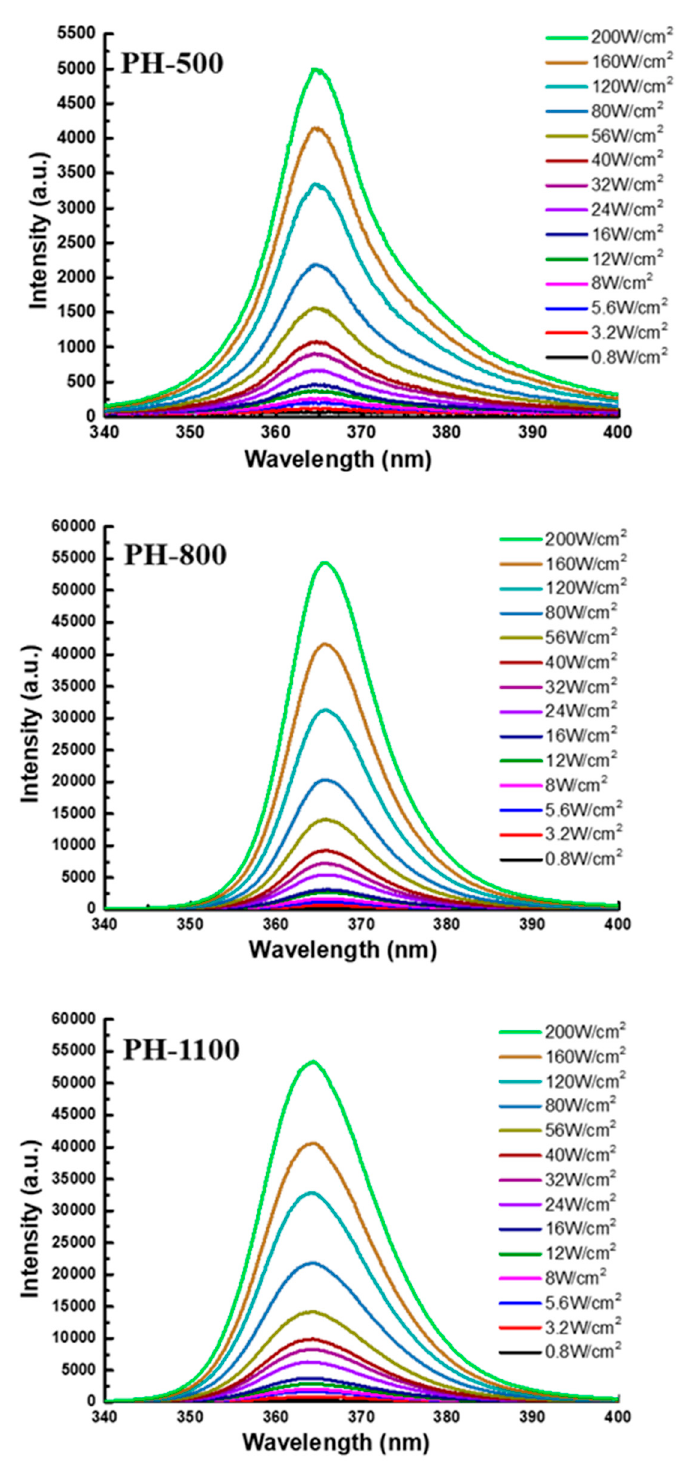
Figure 7. The power-dependent photoluminescence (PL) of the GaN films on PH-500, PH-800, and